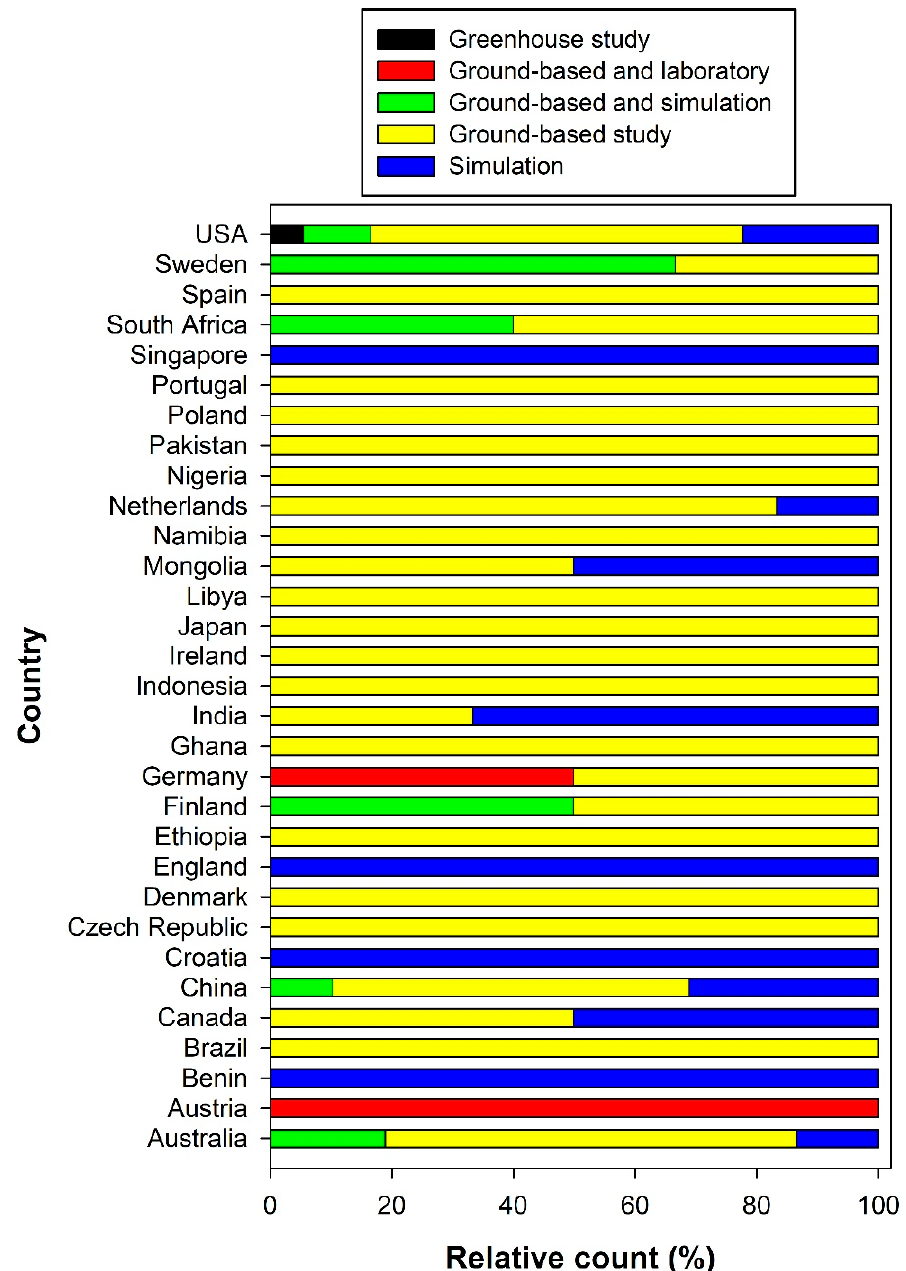
Figure 3. Type of groundwater–vegetation research conducted across the globe.